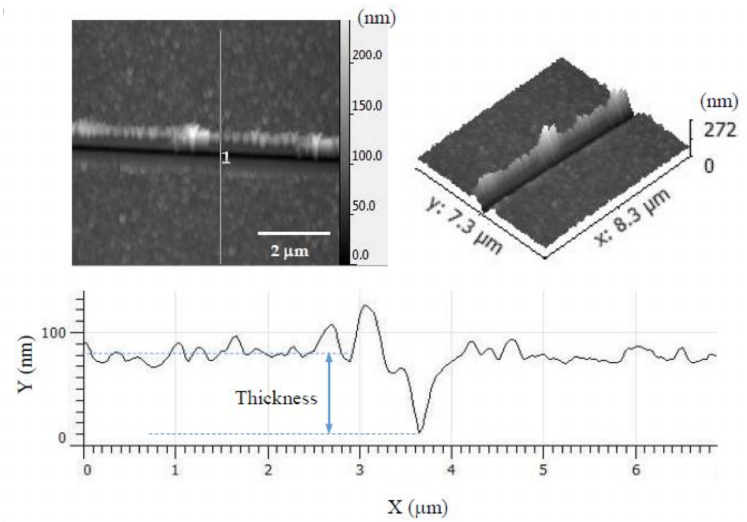
Figure 11. AFM images and height profile of the scratch made on the surface of PDDA/PAA-CSH with 25 bilayers after heat